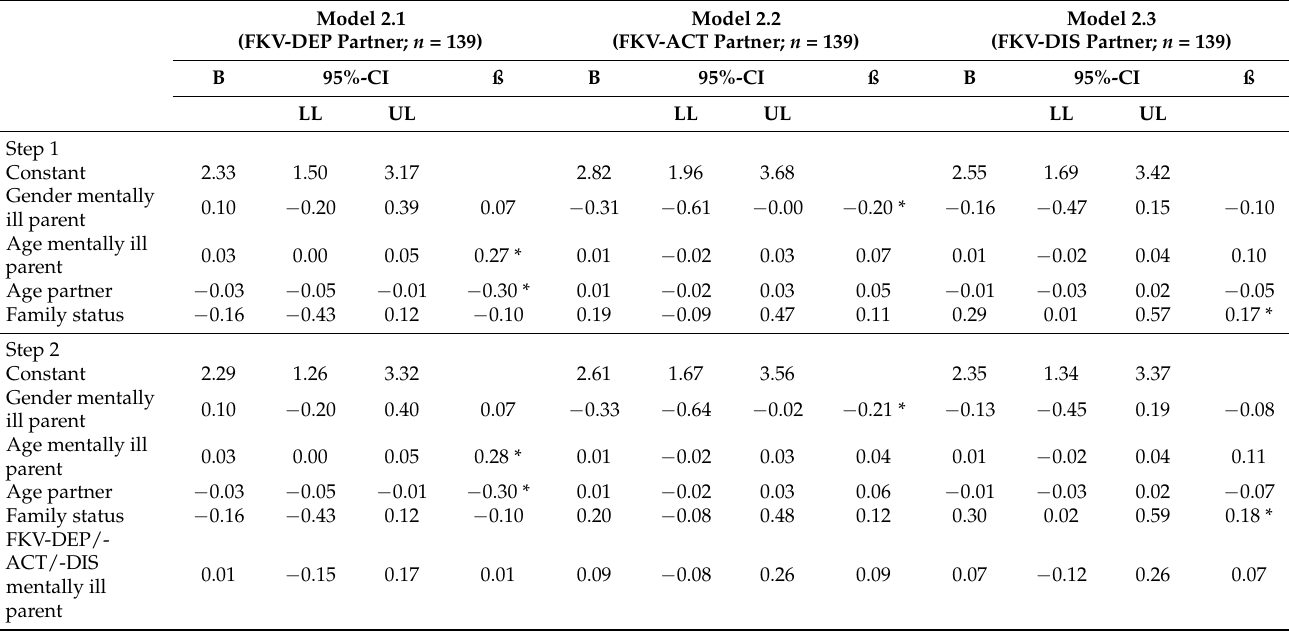
Table 5. Hierarchical regression analyses predicting partners’ symptom coping strategies using FKV-DEP, FKV-ACT, and FKV-DIS scores.